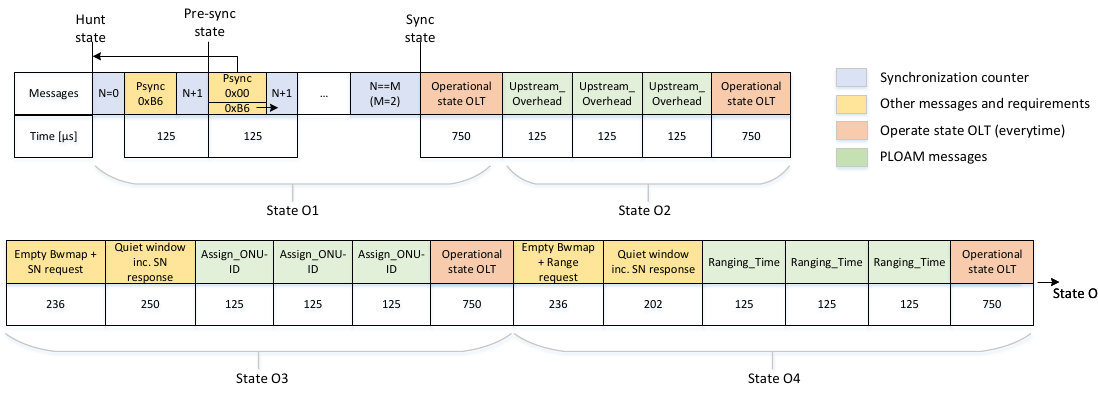
Figure 4. Visualization of the GPON